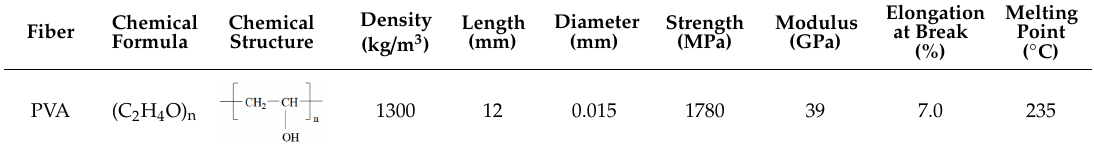
Table 2. Properties of PVA fiber used.